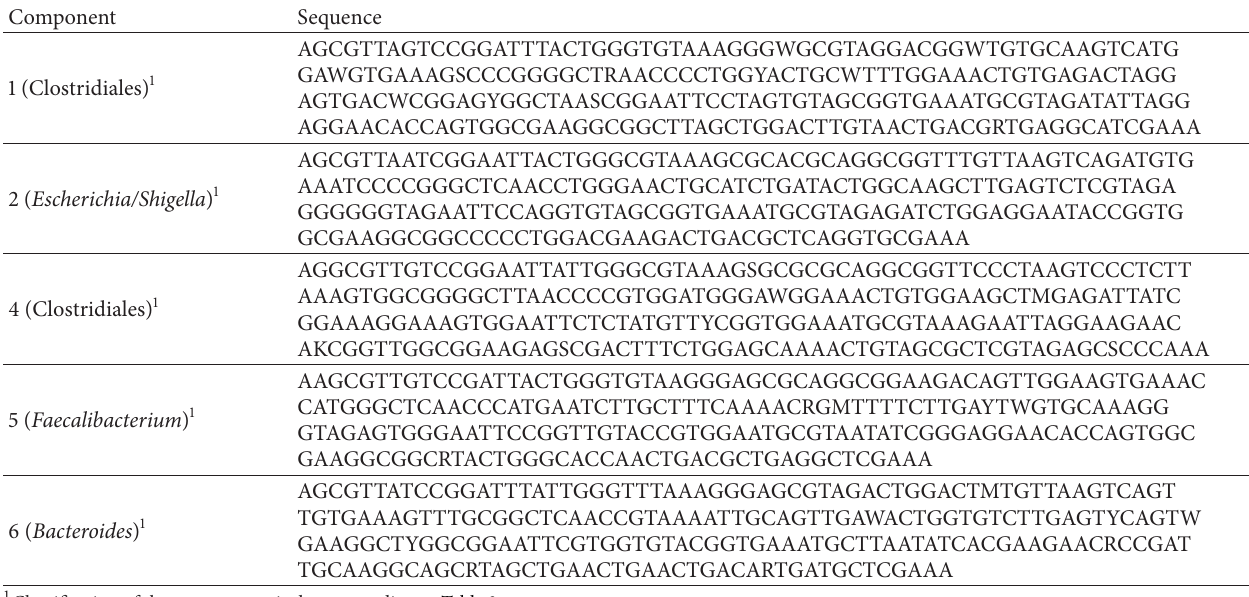
Table 3: Base-called sequences of the five components that showed well resolved spectra obtained from the MCR analysis. Component